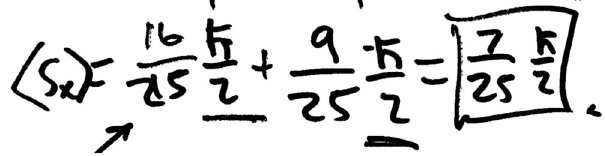
FIG. 6. Irvin ’ s final solution to the expectation value